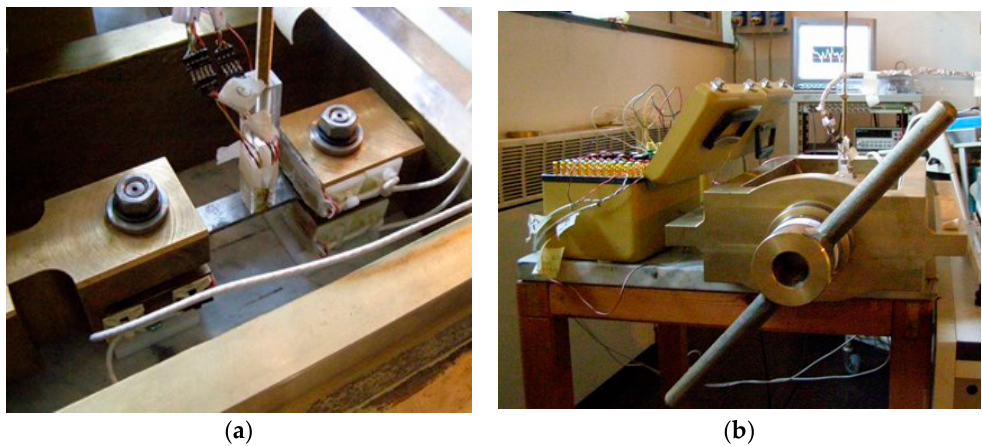
Figure 1. ( a ) Top view of the testing fixture and 2nd order gradiometer assembled on the dog-bone Fe360 at 0.2 mm from sample surface; ( b ) the side view of the testing fixture and details of the brass manual loading knob.